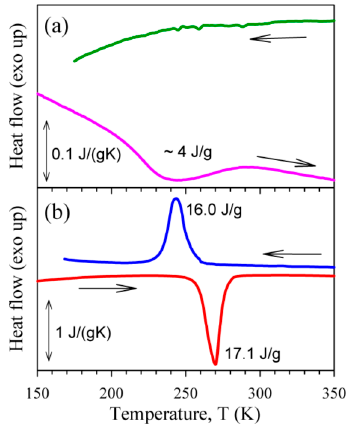
Figure 1. Calorimetry scans for the as-received ( a ) and water-quenched ( b ) Ni 50.8 Ti 49.2 samples.